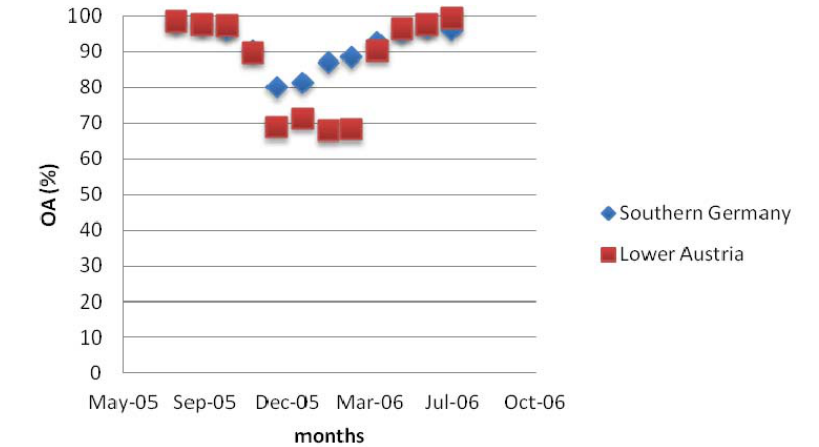
Figure 8. Temporal variability of the overall accuracies (overall accuracy (OA) in %) in the comparison between EURAC snow cover maps (SCA) maps and ground measurements in Southern Germany and Lower Austria for the whole season